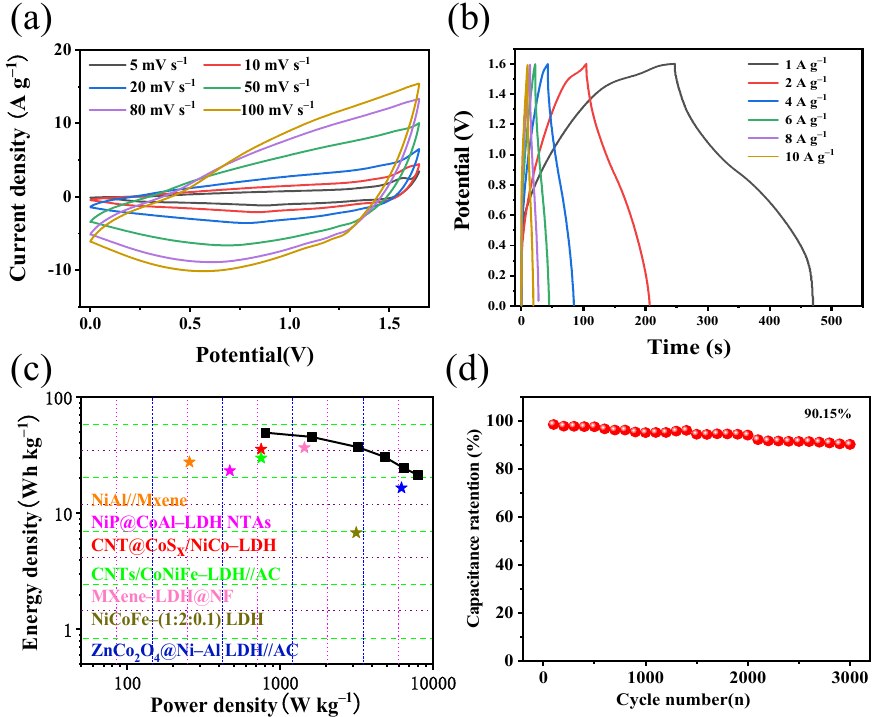
Figure 9. An asymmetric supercapacitor based on NiCoFe–LDH/V 2 CT x –MXene//AC: ( a ) CV curve; ( b ) GCD curve; ( c ) Ragone plot; and ( d ) cycling performance at 10 A g − 1 .